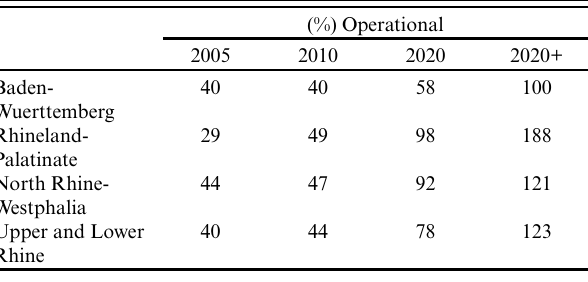
Table 2 . Operational retention volumes Mio m³ as percent of the planned capacity (source: IKSR 2006,